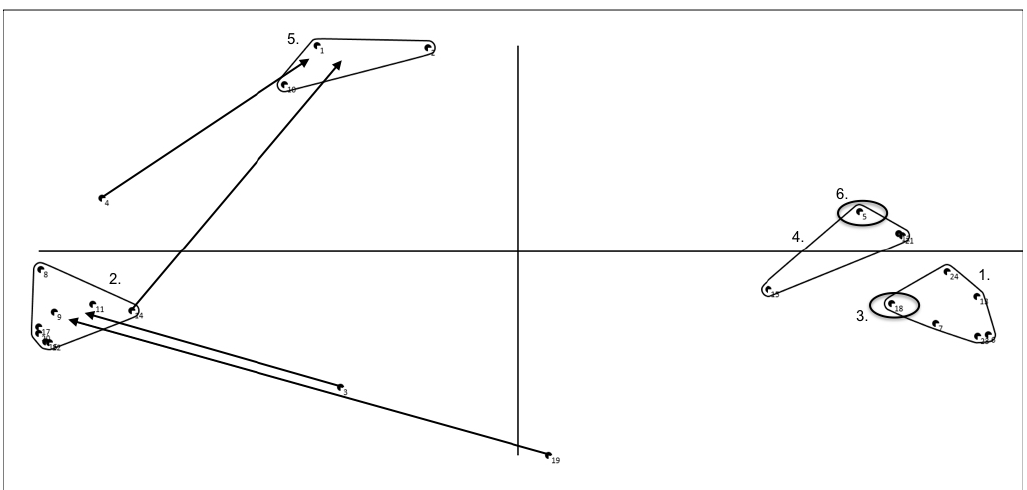
Figure A4. Concept map parents (purposive sample). Note that points, i.e., statements, sorted more often together appear closer to each other, and statements never/rarely sorted together appear widely separated; Arrows indicate a statement is reallocated by researchers, circles indicate a new cluster is created by researchers as a result of reallocation of statements; Cluster 1: My child sits because he/she it tired, wants to relax, wants to rest; Cluster 2: My child sits because he/she can work/play better that way; Cluster 3: My child sits because seated activities are fun; Cluster 4: My child sits because there is nothing to do; Cluster 5: My child sits because it is the norm; Cluster 6: My child sits because it is a habit.